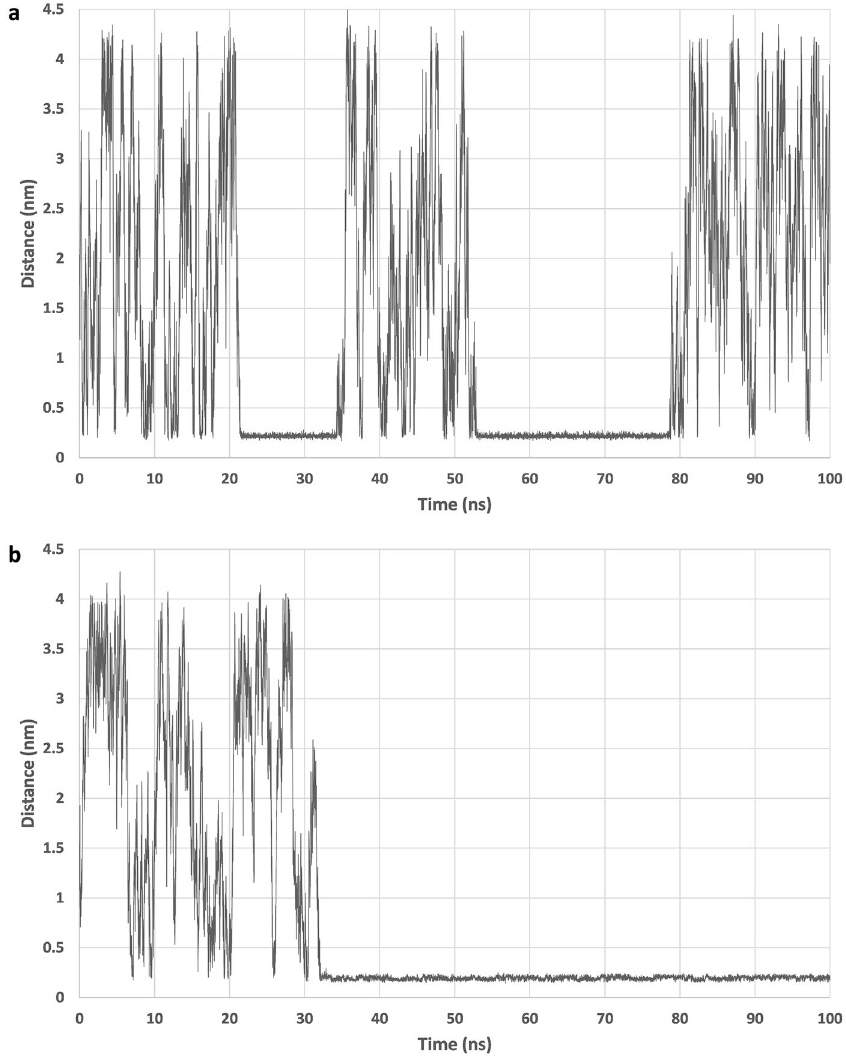
Figure 2. Distance from membrane. ( a ): The distance of PE monomer from the POPC membrane atoms plotted with respect to simulation time in a single selected example simulation run. Figure shows random movement in water at first until at 22 ns the molecule moved inside the membrane, exited at 35 ns and did another enter and exit between 52 and 78 ns. ( b ): PET monomer showed random movement in water at first but entered the membrane at 30 ns and remained there until the end of the